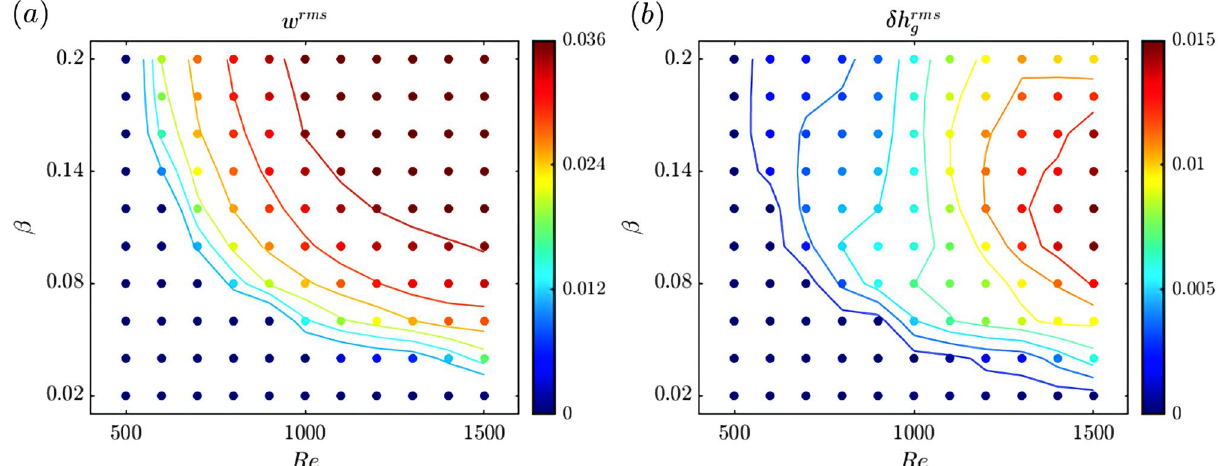
Figure 6. Parametric sweep of ( Re , β) combinations and the resulting long-term rms of the vertical velocity and grass height perturbation, for r = 0.5 , (cid:31) = 1 , and Fr 2 = 0.1 . Contour plots for ( a ) w rms tracking instability from the flow perspective, and ( b ) δ h rms g from the seagrass bed perspective. Lines represent contour levels.